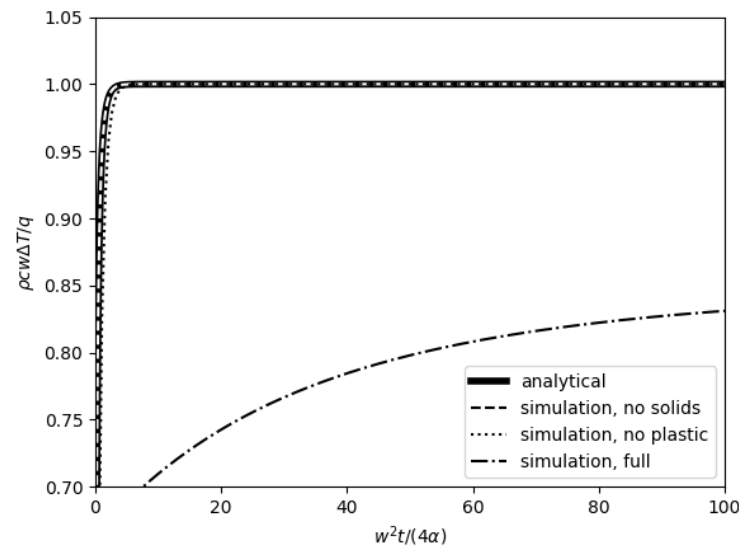
Figure 12. Average silicon temperature for Figure 11. Average silicon temperature for printhead.